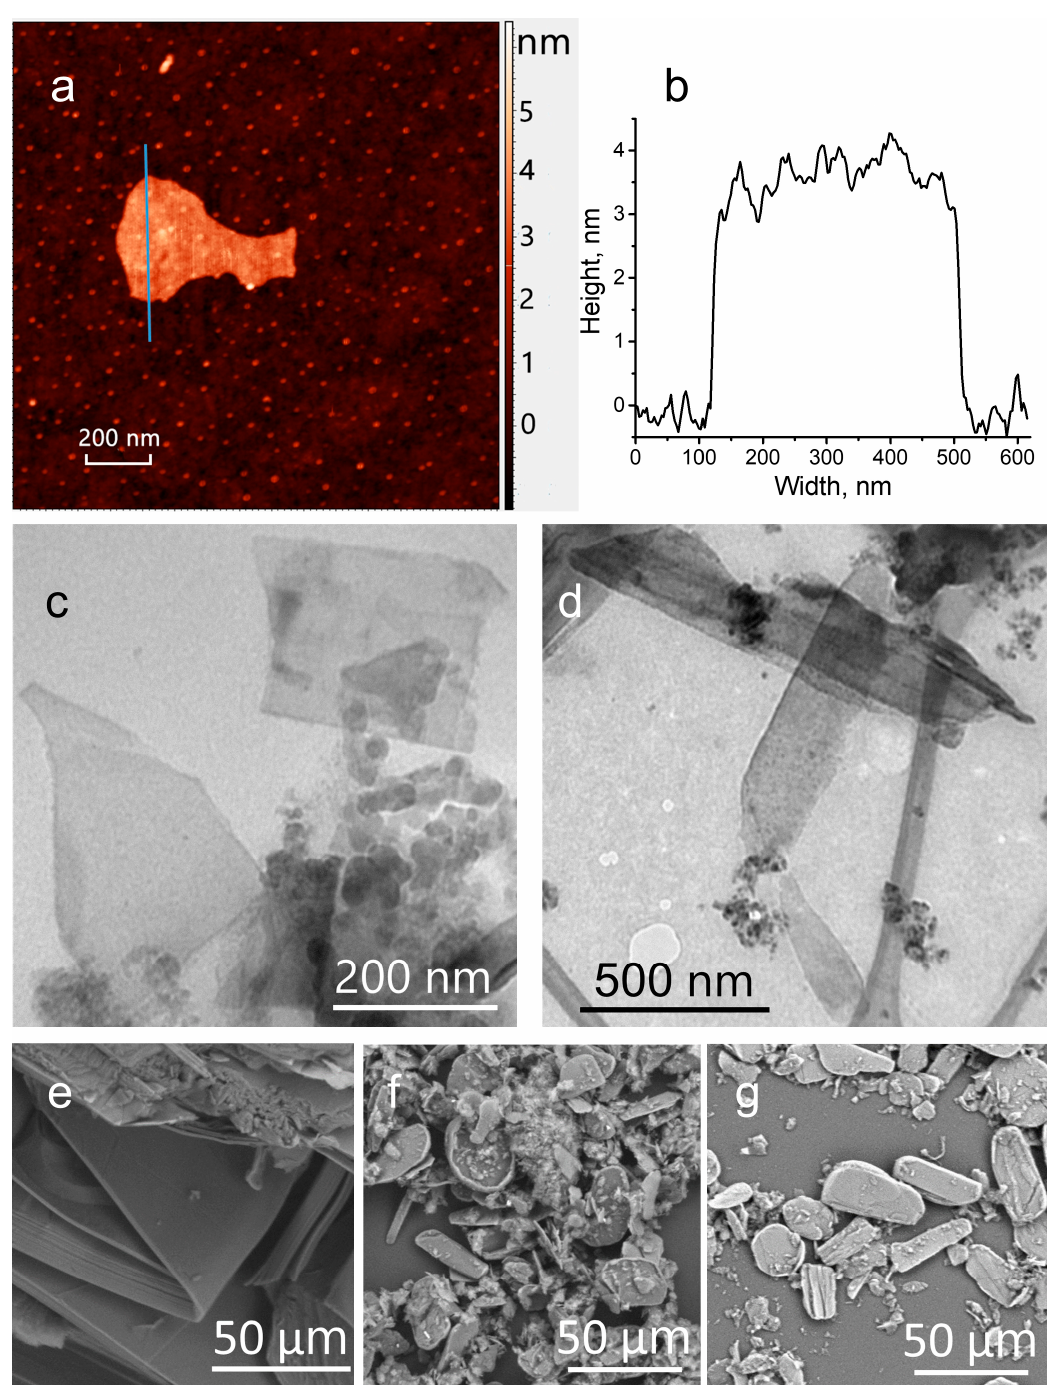
Figure 2. ( a ) AFM image of BPNS. ( b ) Cross-section of BPNS taken from the blue line of the AFM image. TEM images of BPNS ( c ) and BP–CCl 2 ( d ). SEM images of BP crystal ( e ), BPNS ( f ), and BP–CCl 2 ( g ).